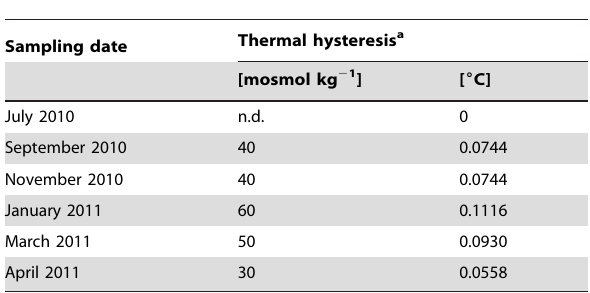
Table 2. Thermal hysteresis between the melting and freezing points in hemolymph samples taken from field- collected caterpillars of Cydia pomonella